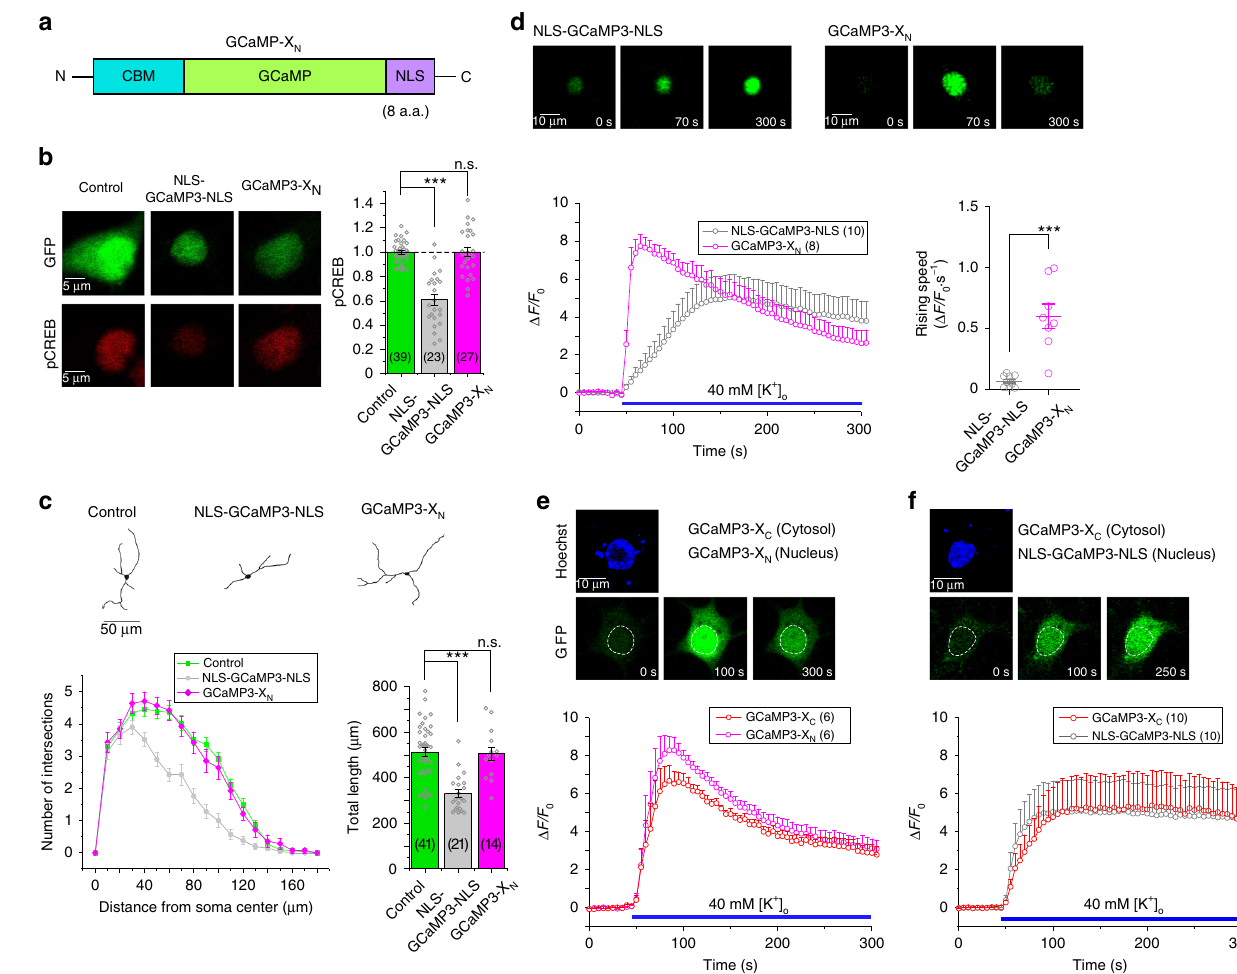
Fig. 7 Characterizations and validations of GCaMP-X N targeting nuclear Ca 2 + . a Design of GCaMP-X N . Based on the design principle of GCaMP-X, similar to GCaMP-X C , CBM was fused into N-terminus of GCaMP; and a nuclear localization signal (NLS) was tagged onto C-terminus of GCaMP. b , c Basic validations of GCaMP3-X N with pCREB signals and neurite outgrowth. Representative images of pCREB immunostaining ( b , left), statistical summary of pCREB intensities ( b , right), tracing of neurite morphology ( c , upper), Sholl analysis and statistical summary of neurite length ( c , lower) were compared among neurons transfected with YFP, NLS-GCaMP3-NLS or GCaMP3-X N . d Different Ca 2 + dynamics resulted from neurons expressing NLS-GCaMP3-NLS or GCaMP3-X N . Confocal images representing Ca 2 + fl uorescence at three phases: before, during and at the end of extracellular stimuli of 40 mM [K + ] o (upper). Ca 2 + response ( Δ F/F 0 ) (lower left) and its rising speed ( Δ F/F 0 · s − 1 , normalized change of fl uorescence per second, lower right) were averaged from multiple neurons (number indicated within parentheses), to compare NLS-GCaMP3-NLS with GCaMP3-X N . e , f Simultaneous monitoring of cytosolic and nuclear Ca 2 + dynamics. Representative confocal images indicative of Ca 2 + fl uorescence (upper in green) and time-dependent responses ( Δ F/F 0 , lower) are to compare Ca 2 + dynamics in the cytosol vs. the nucleus of the same neuron upon 40 mM [K + ] o stimuli. Cytosolic Ca 2 + was monitored by GCaMP3-X C for both cases, whereas nuclear Ca 2 + was either by GCaMP3-X N ( e ) or by NLS-GCaMP3-NLS ( f ). Neurons were loaded with Hoechst 33342 to label the nuclei of neurons (upper, blue). Standard error of the mean (S.E.M.) and Student ’ s t -test (two-tailed unpaired with criteria of signi fi cance: * p < 0.05; ** p < 0.01, and *** p < 0.001) were calculated when applicable, and n.s. denotes “ not signi fi cant